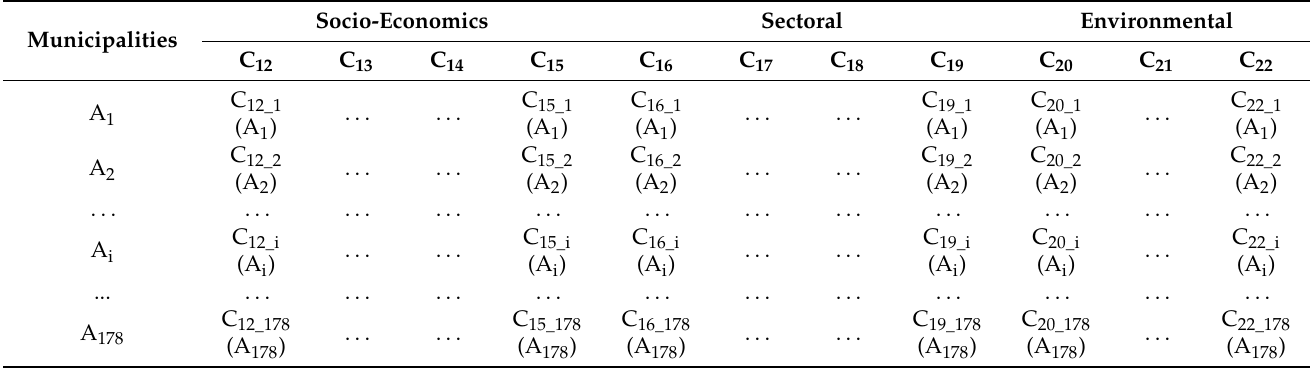
Table 5. Evaluation table of alternatives.